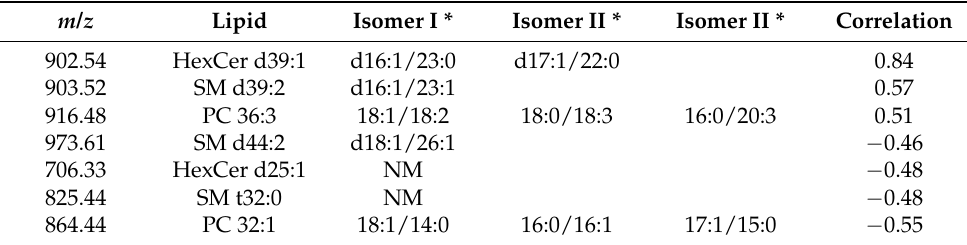
Table 1. List of the seven peaks that present significant correlations with haptoglobin, its lipid assignment, and their isomers. The species found in this table are ionized with